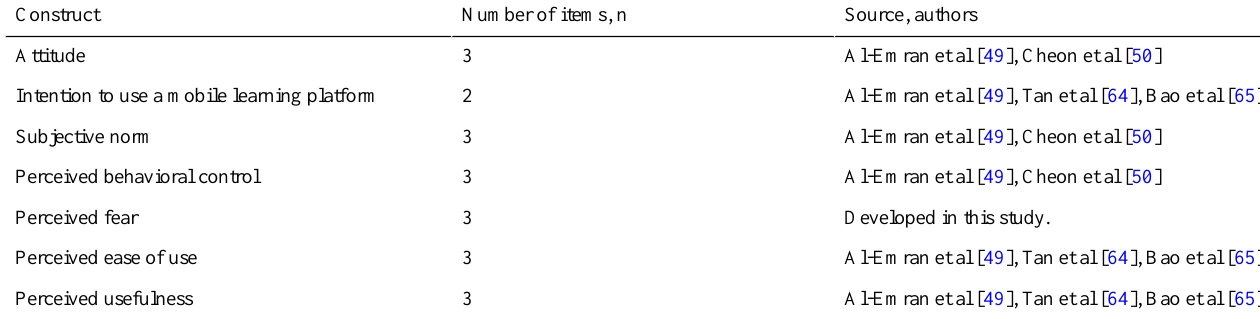
Table 3. Constructs and their